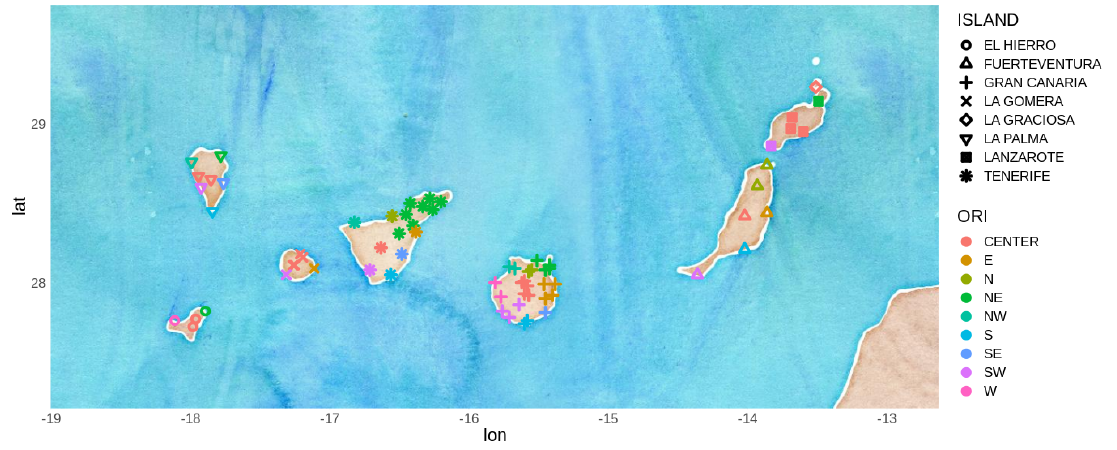
Figure 1. Agencia Estatal de Meteorología (AEMET) weather stations in the Canary